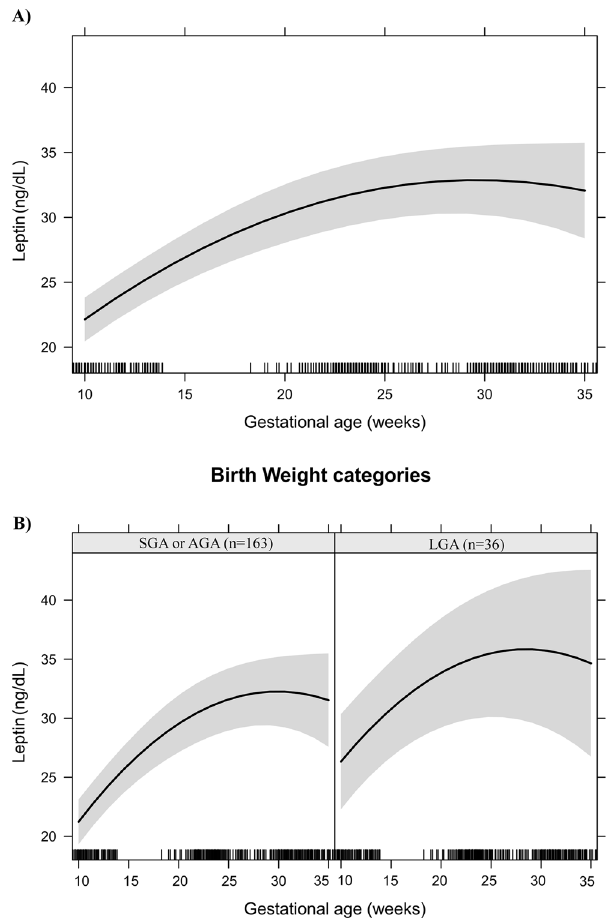
Figure 5. Leptin changes during pregnancy in a sample of 199 women and their newborns followed at a public health centre in Rio de Janeiro city, Brazil, 2009–2012. ( A ) Change per gestational week. ( B ) Change per gestational week according to birth weight categories. Note: The models were adjusted for age, education, smoking habit, pre-pregnancy leisure time physical activity, pre-pregnancy energy intake, glycaemia, parity, early pregnancy BMI, gestational weight gain and quadratic gestational age. Data are presented as linear mixed effect coefficient ( β ) and 95% CI. p-value refers to the maximum likelihood estimator. ( A ) Linear gestational age: β = 1.60 (0.98; 2.22), p < 0.001; Quadratic gestational age: β = − 0.027 ( − 0.04; − 0.01), p = 0.001. ( B ) SGA or AGA - Linear gestational age: β = 1.74 (1.07; 2.42), p < 0.001; quadratic gestational age; β = − 0.029 ( − 0.04; − 0.01), p < 0.001. LGA - Linear gestational age: β = 1.33 ( − 0.14; 2.81), p = 0.077; gestational age; β = − 0.02 ( − 0.06; − 0.01), p =